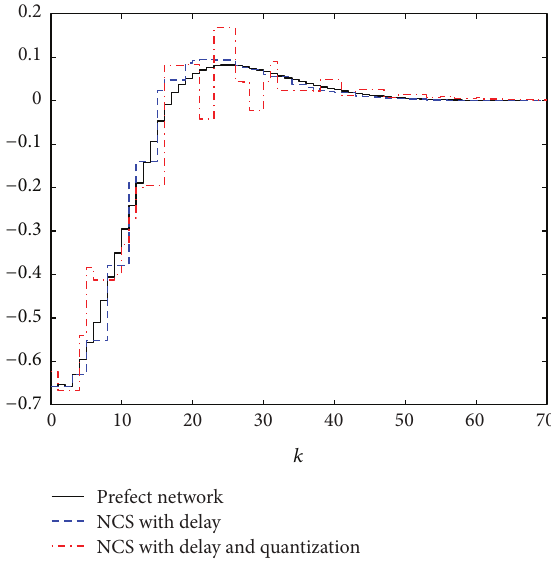
Figure 7: The control input (Example